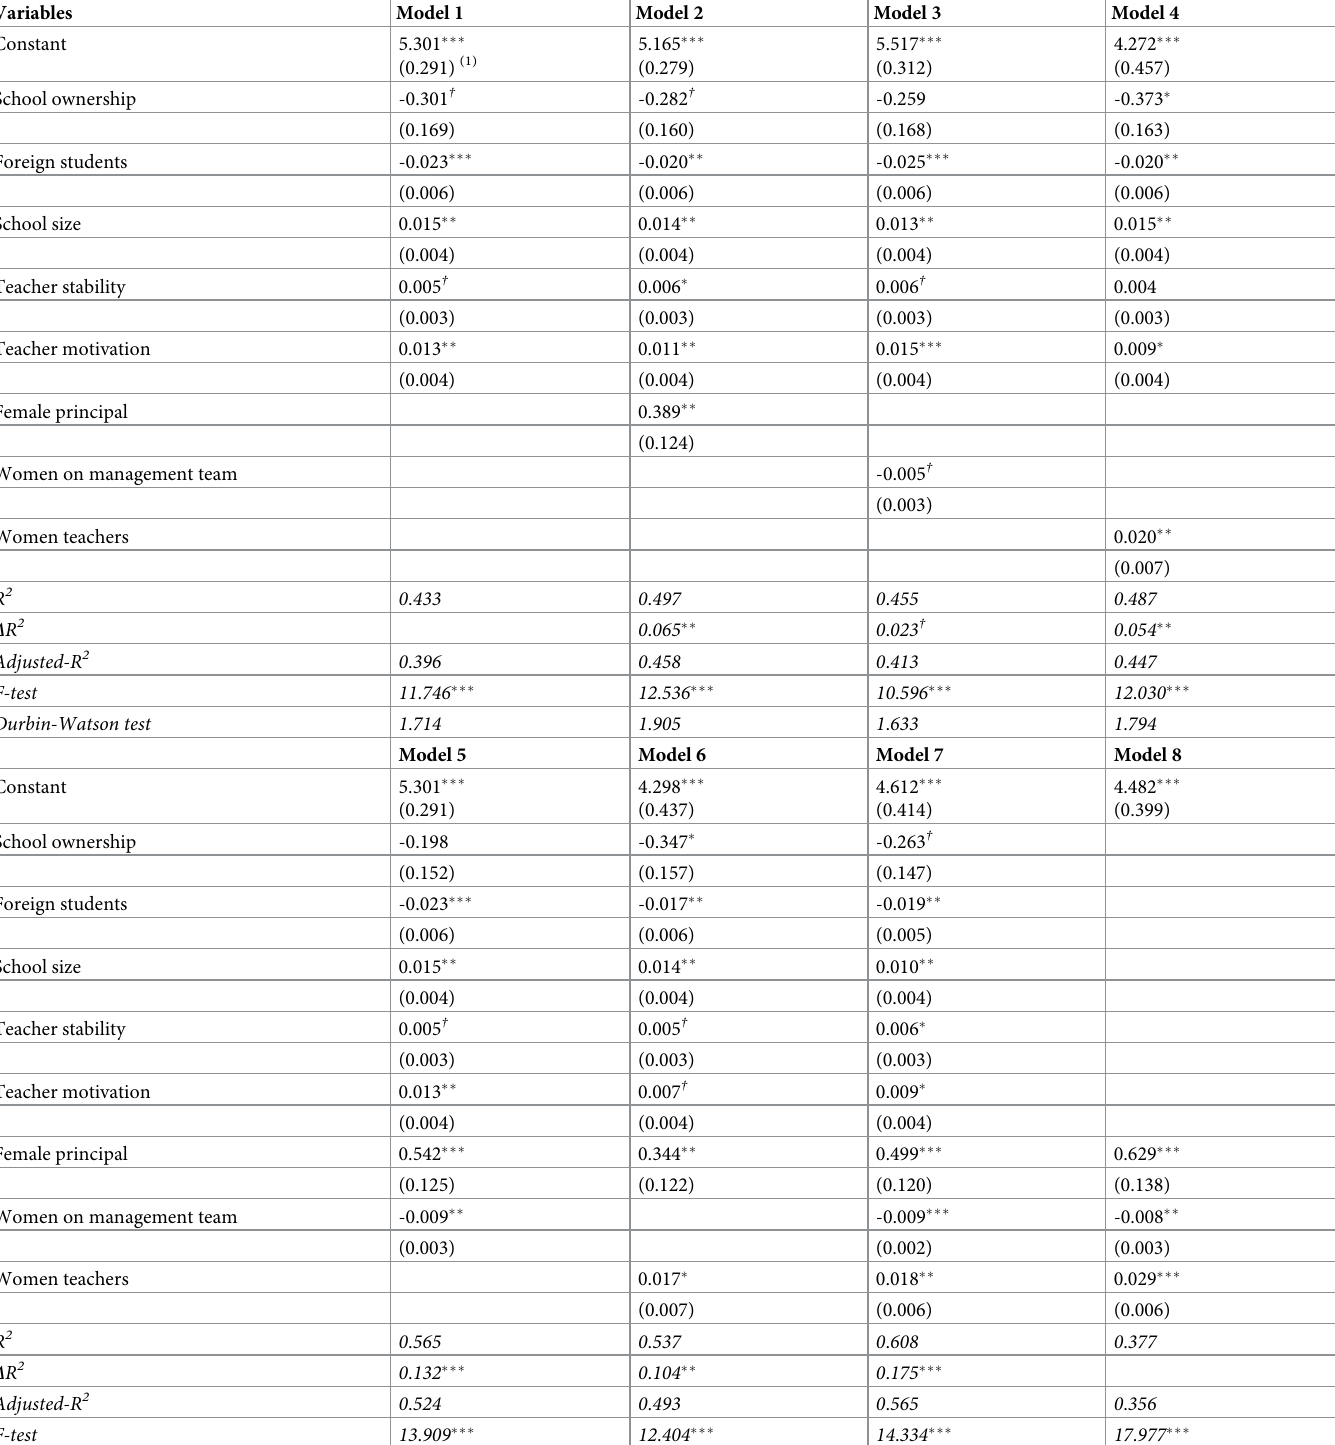
Table 2. Hierarchical multiple regression analysis (dependent variable = School students’ achievement